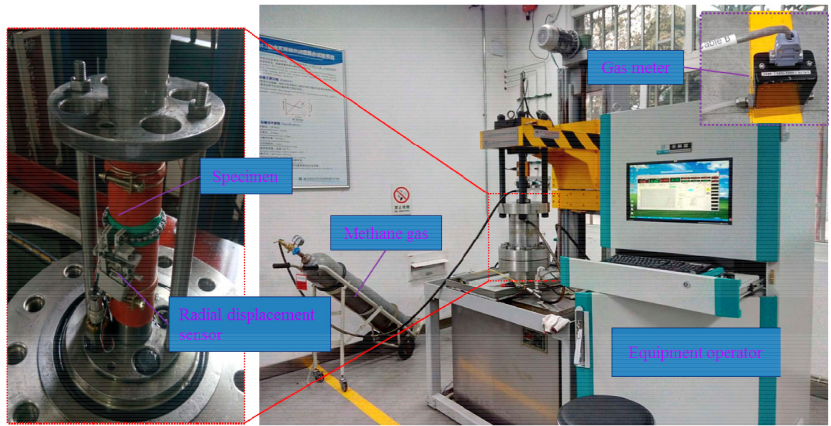
Figure 1. Thermal-fluid-solid coupling triaxial servo seepage device.